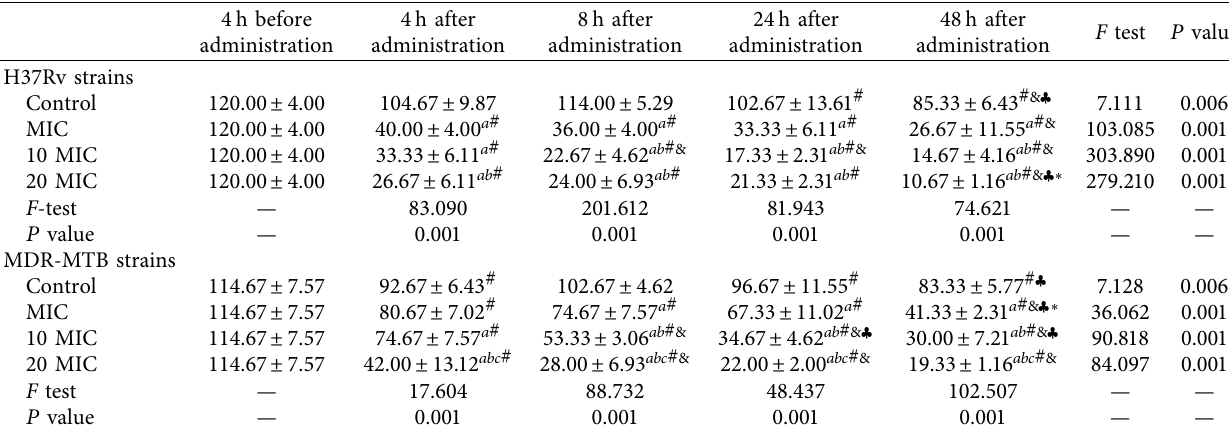
Table 1: Cytotoxicity test after Bdq treatments (OD